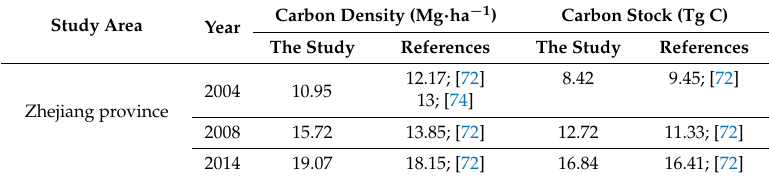
Figure 9. The test sample standardized residual in different years. Table 8. The results were compared on the AGC of Bamboo Forest in Zhejiang Province.